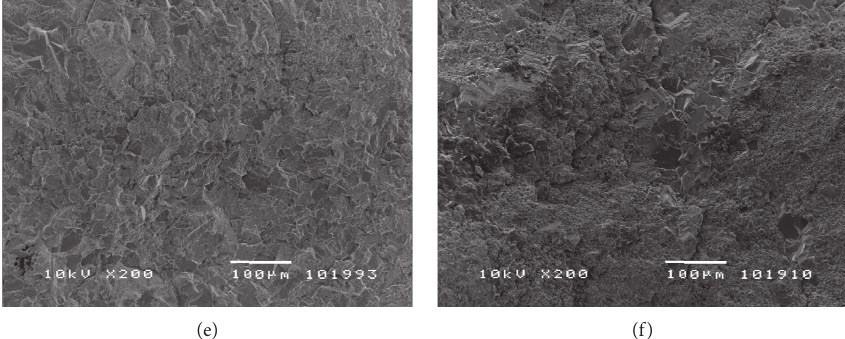
Figure 20: Fracture morphology of marble in different temperatures. (a) 25 ° C, × 200, (b) − 5 ° C, × 200, (c) − 10 ° C, × 200, (d) − 20 ° C, × 200, (e) − 30 ° C, × 200, and (f) 40 ° C, × 200.